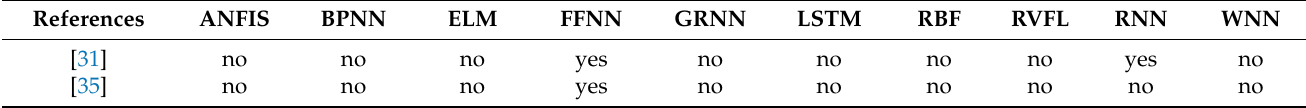
Table 4. List of papers that make use of any neural network methodology. ANFIS: Adaptive